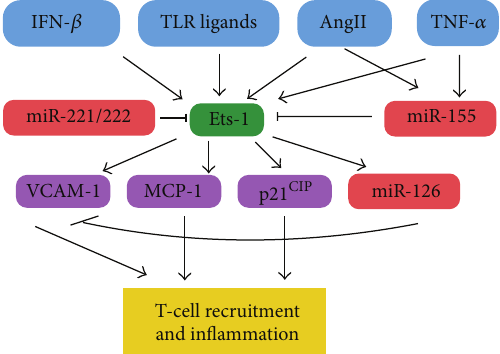
Figure 3: The interaction of miR-155, miR-221/222, and miR-126 in regulation of Ets-1 driven endothelial cell inflammation. A variety of proinflammatory extracellular factors induce Ets-1 transcription whichsubsequentlyinducesexpressionofECproteinsinvolvedinT- cell recruitment. miR-155 and miR-221/222 act to reduce translation of Ets-1, while miR-126 acts further downstream to reduce VCAM-1